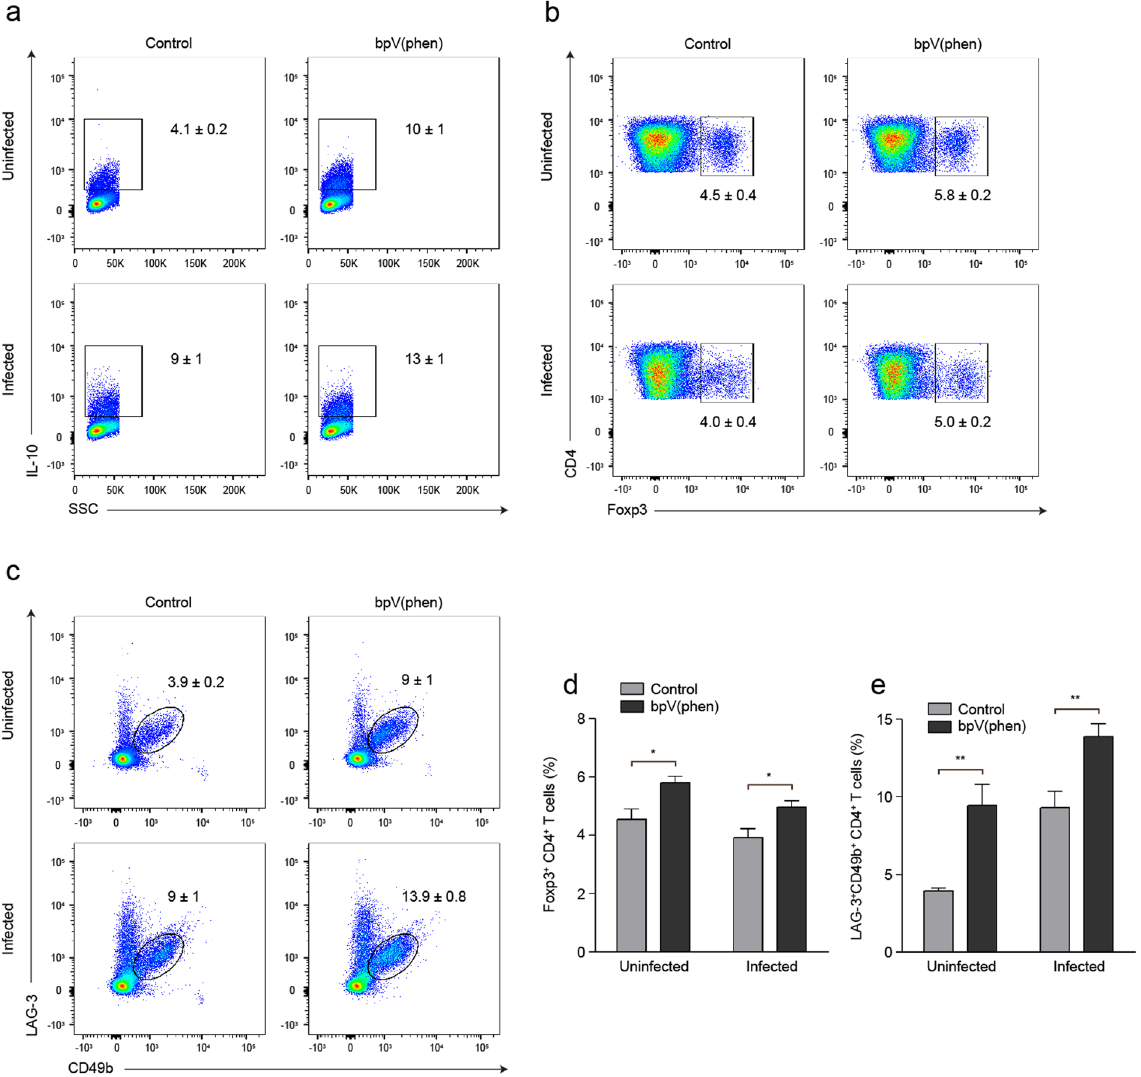
Figure 2. bpV(phen) treatment increases the frequency of regulatory CD4 + T cells in the spleen. Representative flow cytometry plots of ( a ) IL-10 + CD4 + T cells, ( b ) Foxp3 + and ( c ) LAG-3 + CD49b + CD4 + T cells, and the percentage of ( d ) Foxp3 + and ( e ) LAG-3 + CD49b + CD4 + T cells measured on day 7 post-infection after PMA/ ionomycin stimulation. The numbers shown on the flow cytometry plots indicate the mean percentage of cells inside the gate ± S.E.M. The cumulative average of 2 independent experiments is shown. n = 9 for uninfected, control mice, n = 9 for uninfected, bpV(phen)-treated mice, n = 11 for infected, control mice, and n = 11 for infected, bpV(phen)-treated mice. For the IL-10 + CD4 + T cells, P = 0.0047 for the uninfected control and bpV(phen)-treated mice, and P = 0.0263 of the infected control and bpV(phen)-treated mice. * P < 0.05 and ** P < 0.01. Statistical significance was determined using a one-way ANOVA and Tukey’s multiple comparisons